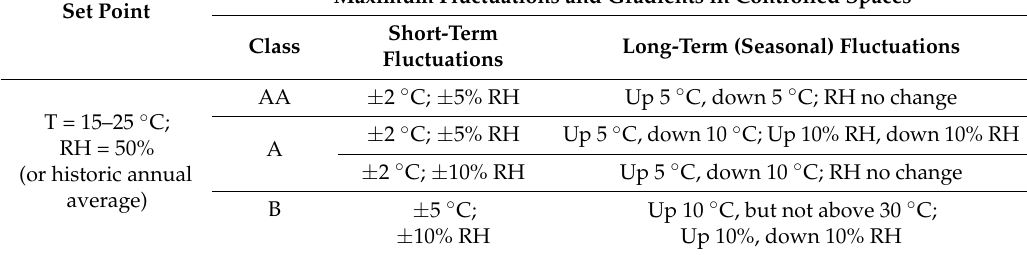
Table 1. The temperature (T) and relative humidity (RH) specifications for collections according to The American Society of Heating Refrigeration and Air-conditioning Engineers (ASHRAE) standards (classes AA, A, and B), adopted from Ferdyn-Grygierek, et al.